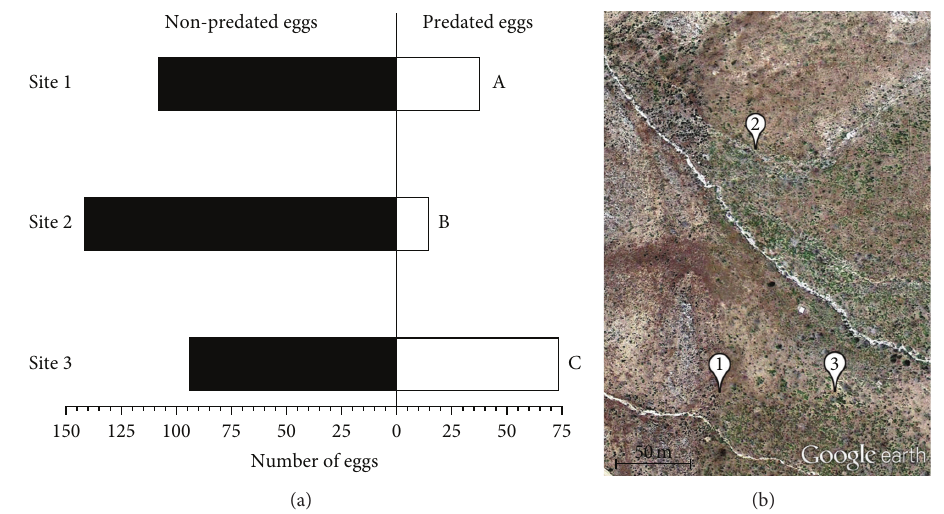
Figure 5: Geocoris spp. predation activity differs among sites within a native N. attenuata population. (a) The graph shows numbers of M. sexta eggs predated over 36 h by Geocoris spp. Letters indicate significant differences between sites in Bonferroni-corrected pairwise Fisher’s exact tests, 𝑃 < 0.003 . (b) Sites were clusters of plants ca. 50–100 m